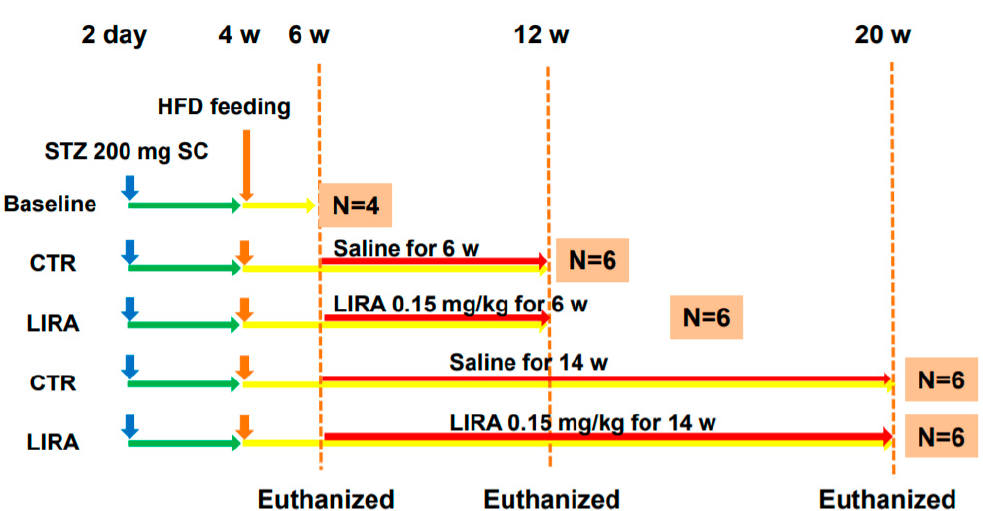
Figure 7. Experimental design and protocol. A total of 200 µg streptozotocin was injected into 15-day-old male mice at 2 days after birth followed by feeding with a high-fat diet after 4 weeks (w) of age. Mice were killed at 6 ( n = 4 for baseline), 12 ( n = 6 / group), and 20 ( n = 6 / group) w of age. Mice were treated with liraglutide or saline for 6 w or 14 w until death. CTR: control mice; LIRA: liraglutide-treated (0.15 mg / kg by subcutaneous injection) mice; STZ: streptozotocin; SC: subcutaneous injection; HFD: high-fat